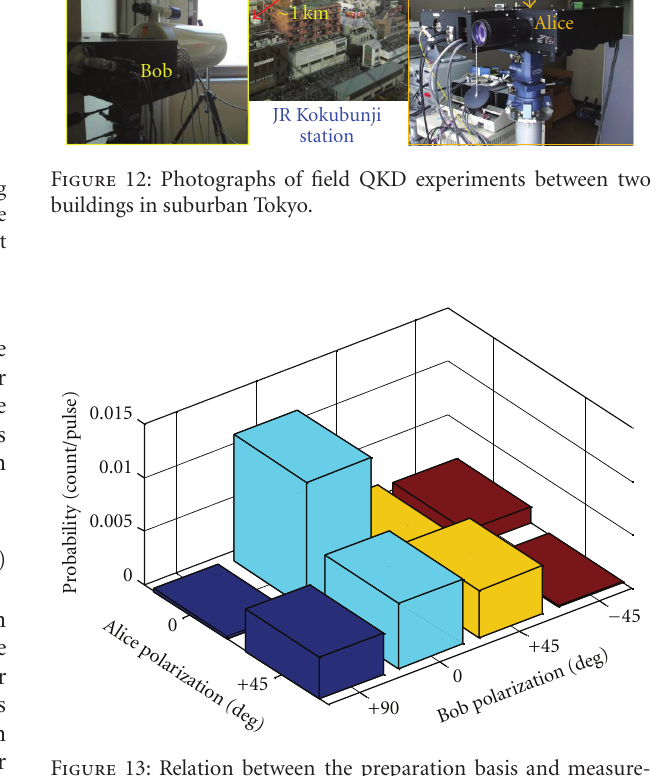
Figure 13: Relation between the preparation basis and measure- ment outcomes measured by Alice and Bob for randomly selected polarizations without the error